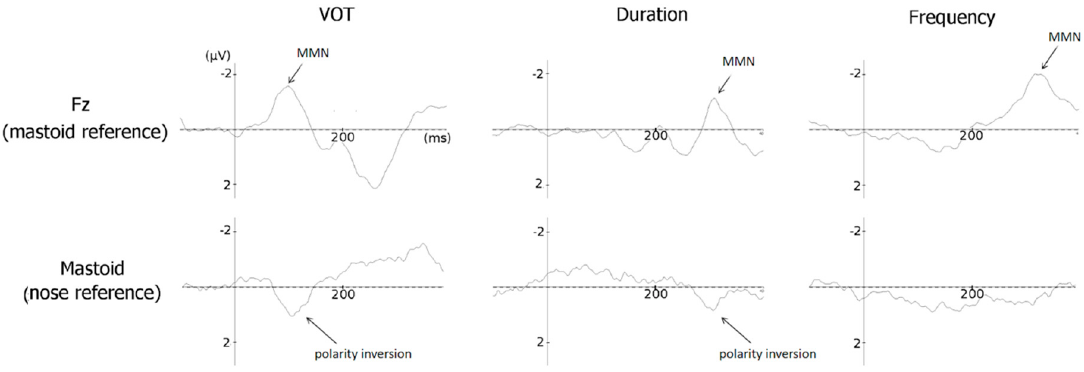
Figure 2. Mismatch Negativities (MMNs—i.e., Event-Related Potentials (ERPs) to the deviant stimuli minus ERPs to standard stimuli) averaged across large and small deviant stimuli and before and after training at Fz (with mastoid reference, top) and at mastoid electrode (mean of left and right mastoid electrodes, with nose reference, bottom) for Voice Onset Time (VOT, left), Duration (middle), and Frequency (right) deviant stimuli. Note the clear polarity inversion between Fz and mastoid for VOT and duration changes but not for frequency